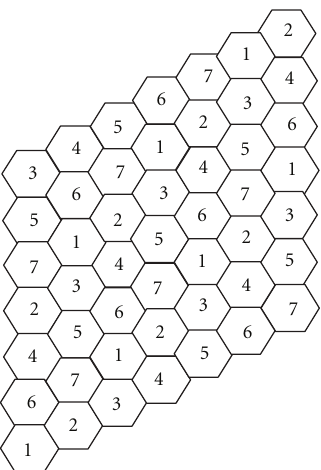
Figure 3: Reuse pattern (reuse distance is